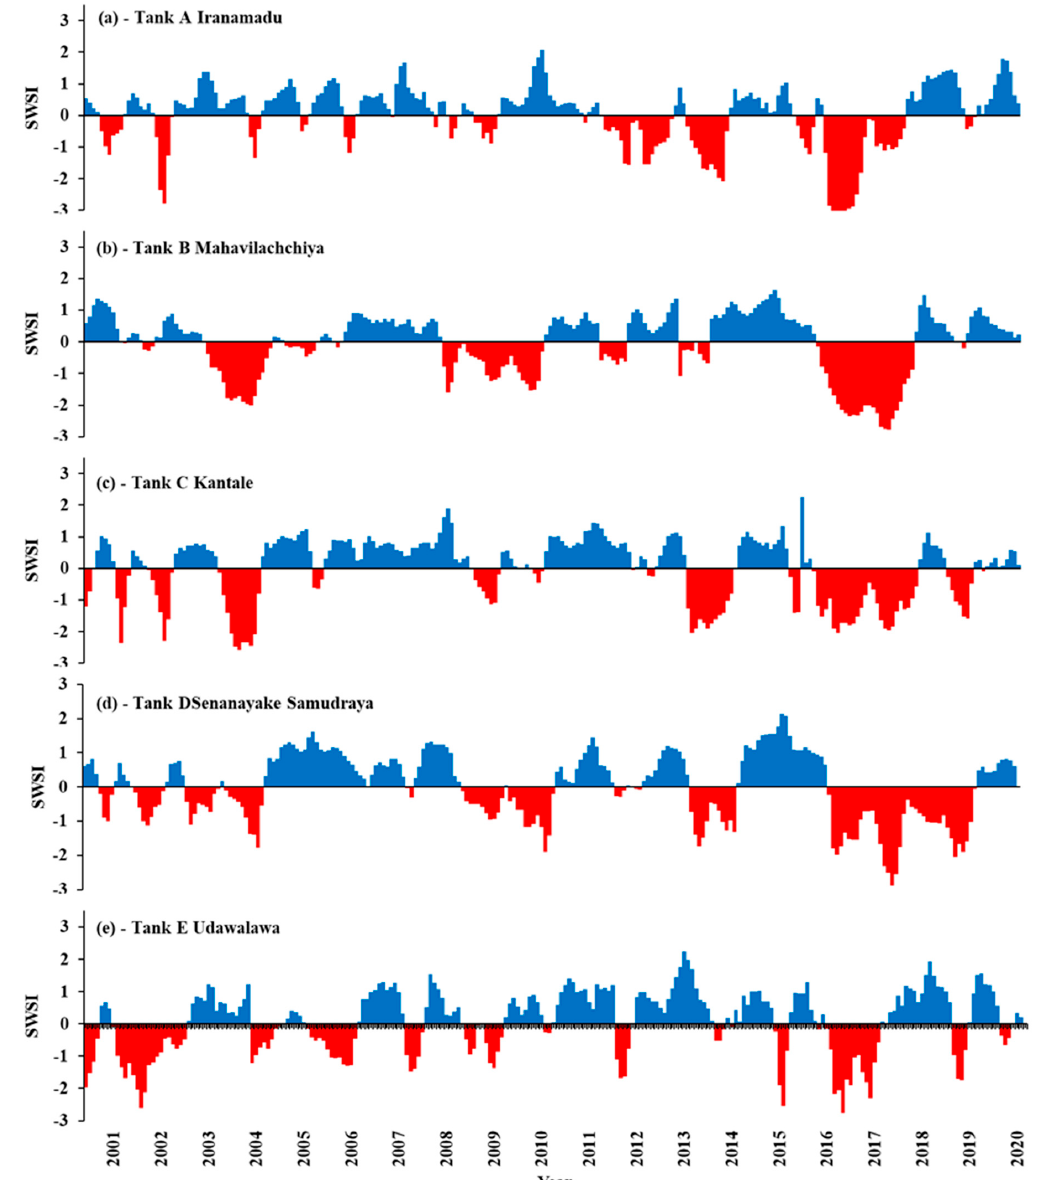
Figure 8. Observed SWSI from 2001 to 2020. ( a )—Tank A (Iranamadu), ( b )—Tank B (Mahavilachchiya), ( c )—Tank C (Kanthale), ( d )—Tank D (Senanayaka Samudraya), ( e )—Tank E (Udavalawa).